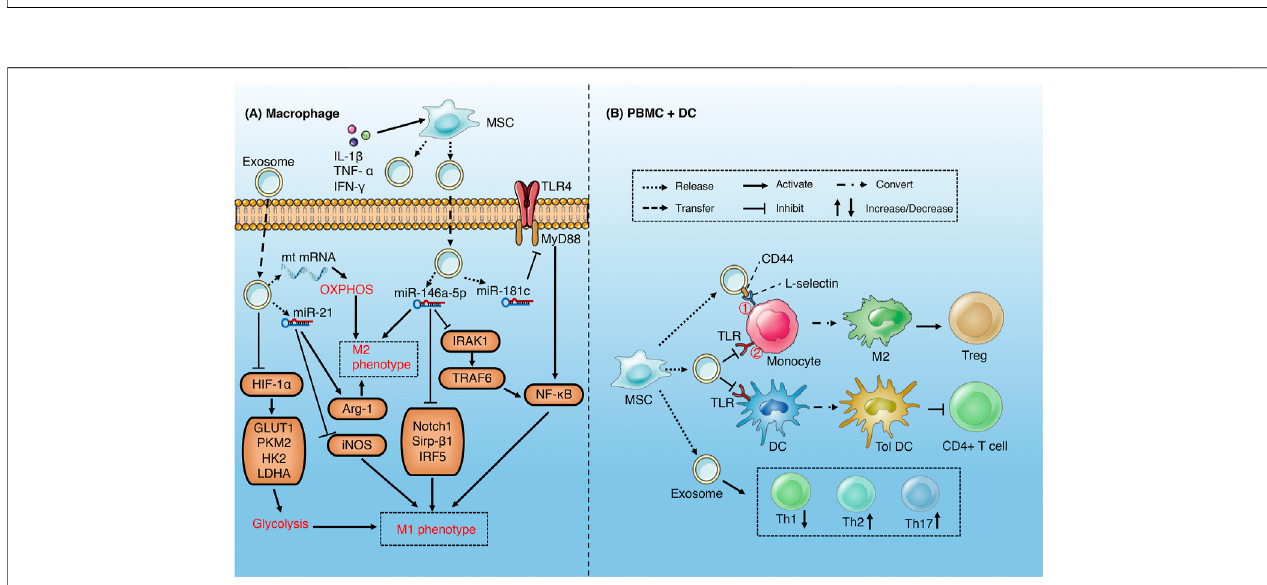
FIGURE 4 | Role of exosomes derived from MSC in sepsis (A) MSC-derived exosomes increase M2 and decrease M1 phenotype of macrophages through metabolism reprogramming and multiple miRNAs-mediated signaling pathways (B) MSC-derived exosomes induce M2-like phenotype in monocytes via activating COX2-PGE2 ① and inhibiting TLR/NF-KB ② signaling pathways, which in turn induce the expansion of Treg. MSCs-derived exosomes induce DCs into a tolerogenic population and modulate the differentiation spectrum of T cell subsets.